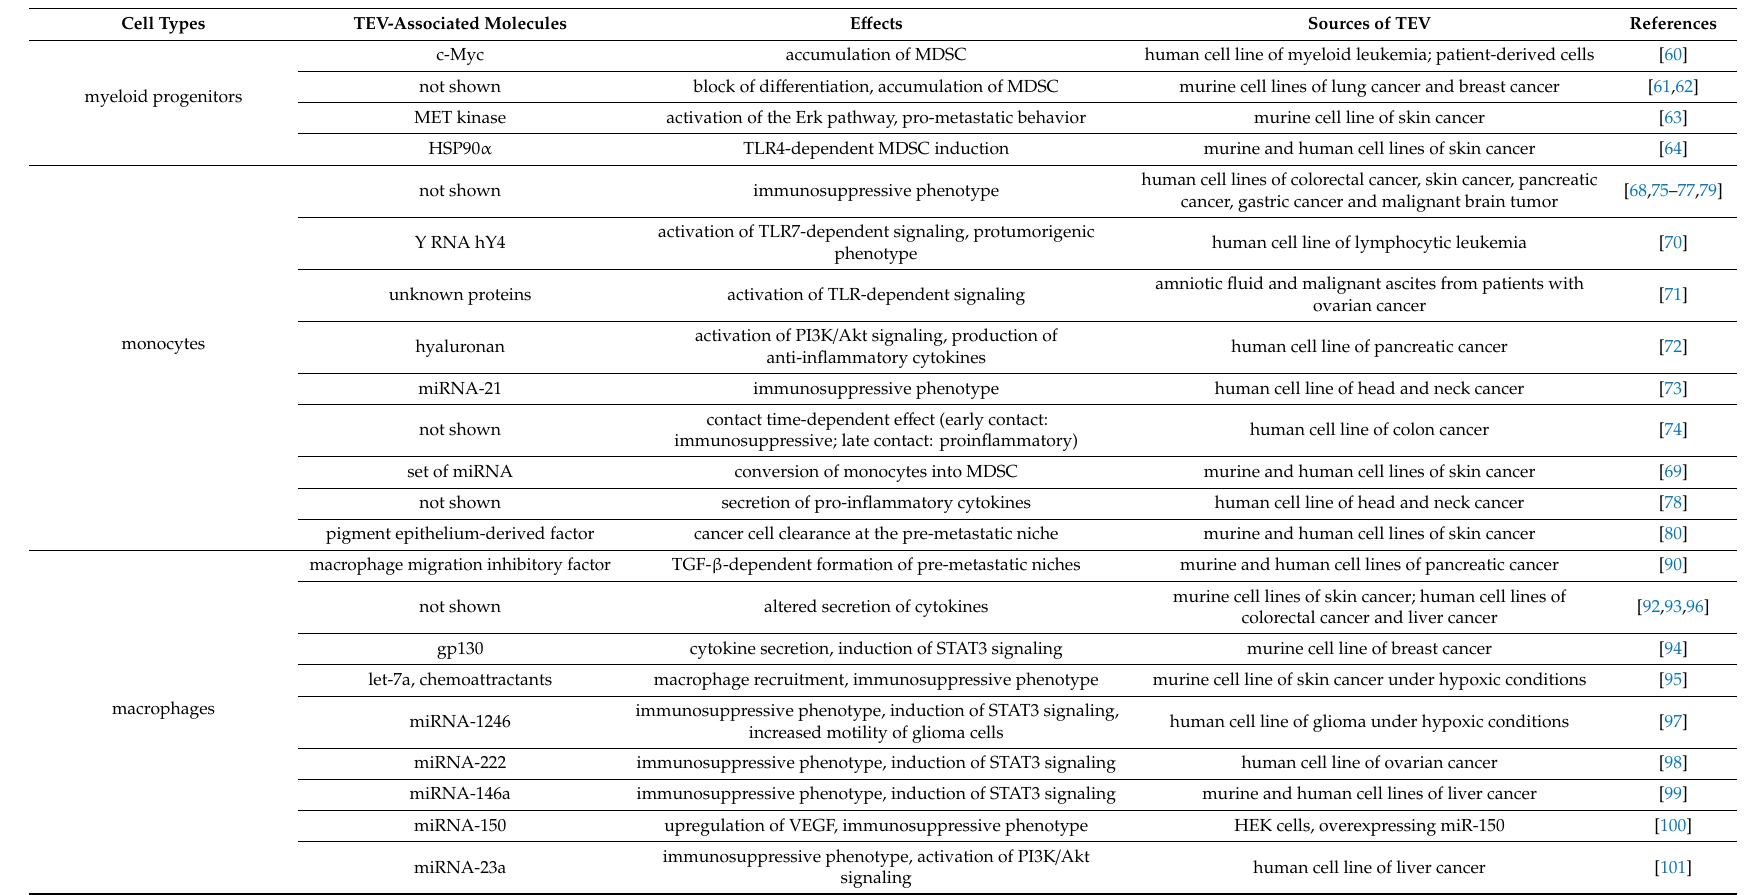
Table 1. E ff ects of TEV on myeloid